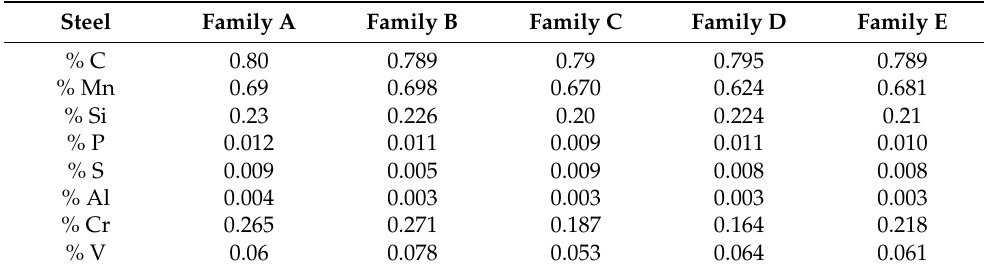
Table 1. Chemical composition (wt.%) for the five families of the steels (the balance is Fe).